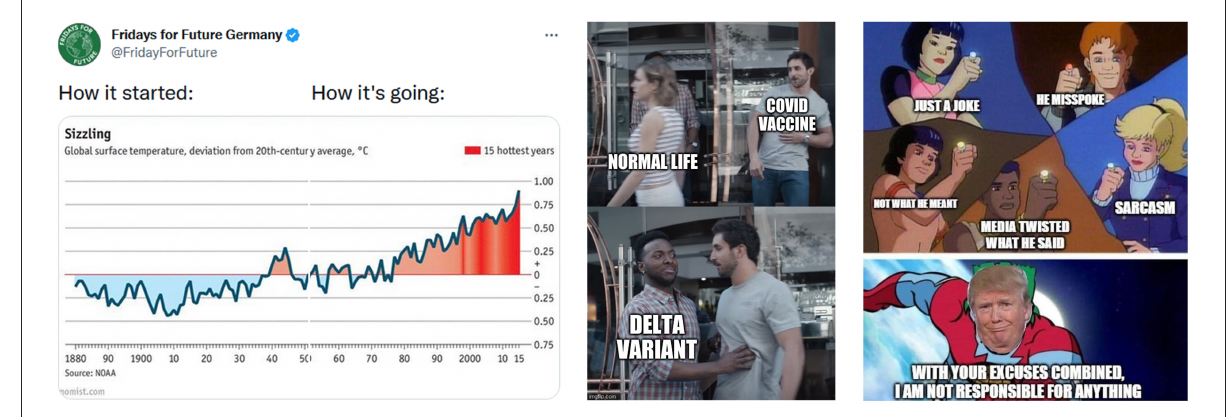
FIGURE1 Types of political Internet memes [ (left) persuasive meme, source: FridayForFuture (2020); (middle) grassroots action meme, source: MapleSyrupSupremacy (2021); (right) public discussion meme, source: KylieFan_89